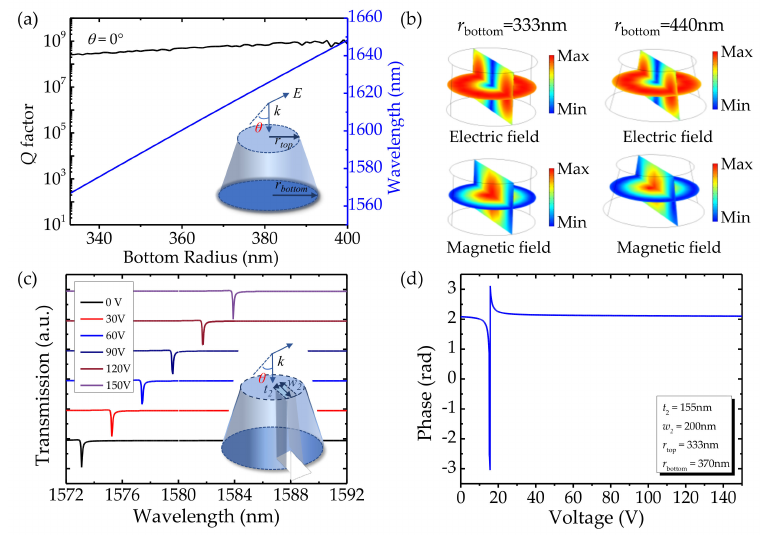
Figure 6. ( a ) The dependence of the Q factors and resonant wavelengths on the radii of the truncated cone. Inset: the schematic diagram of a single LiNbO 3 truncated cone. ( b ) Electric and magnetic field intensity distributions at r bottom = 333 nm ( left ) and 440 nm ( right ). ( c ) The transmission spectra of the LiNbO 3 asymmetric truncated cone calculated for different applied bias voltages with normal incidence. The asymmetric truncated cone: h = 400 nm, r top = 333 nm, r bottom = 440 nm, t 2 = 155 nm, w 2 = 200 nm, θ = 0 ◦ . ( d ) The phase spectrum of the asymmetric truncated cone calculated for different voltages at the operating wavelength of 1574.2